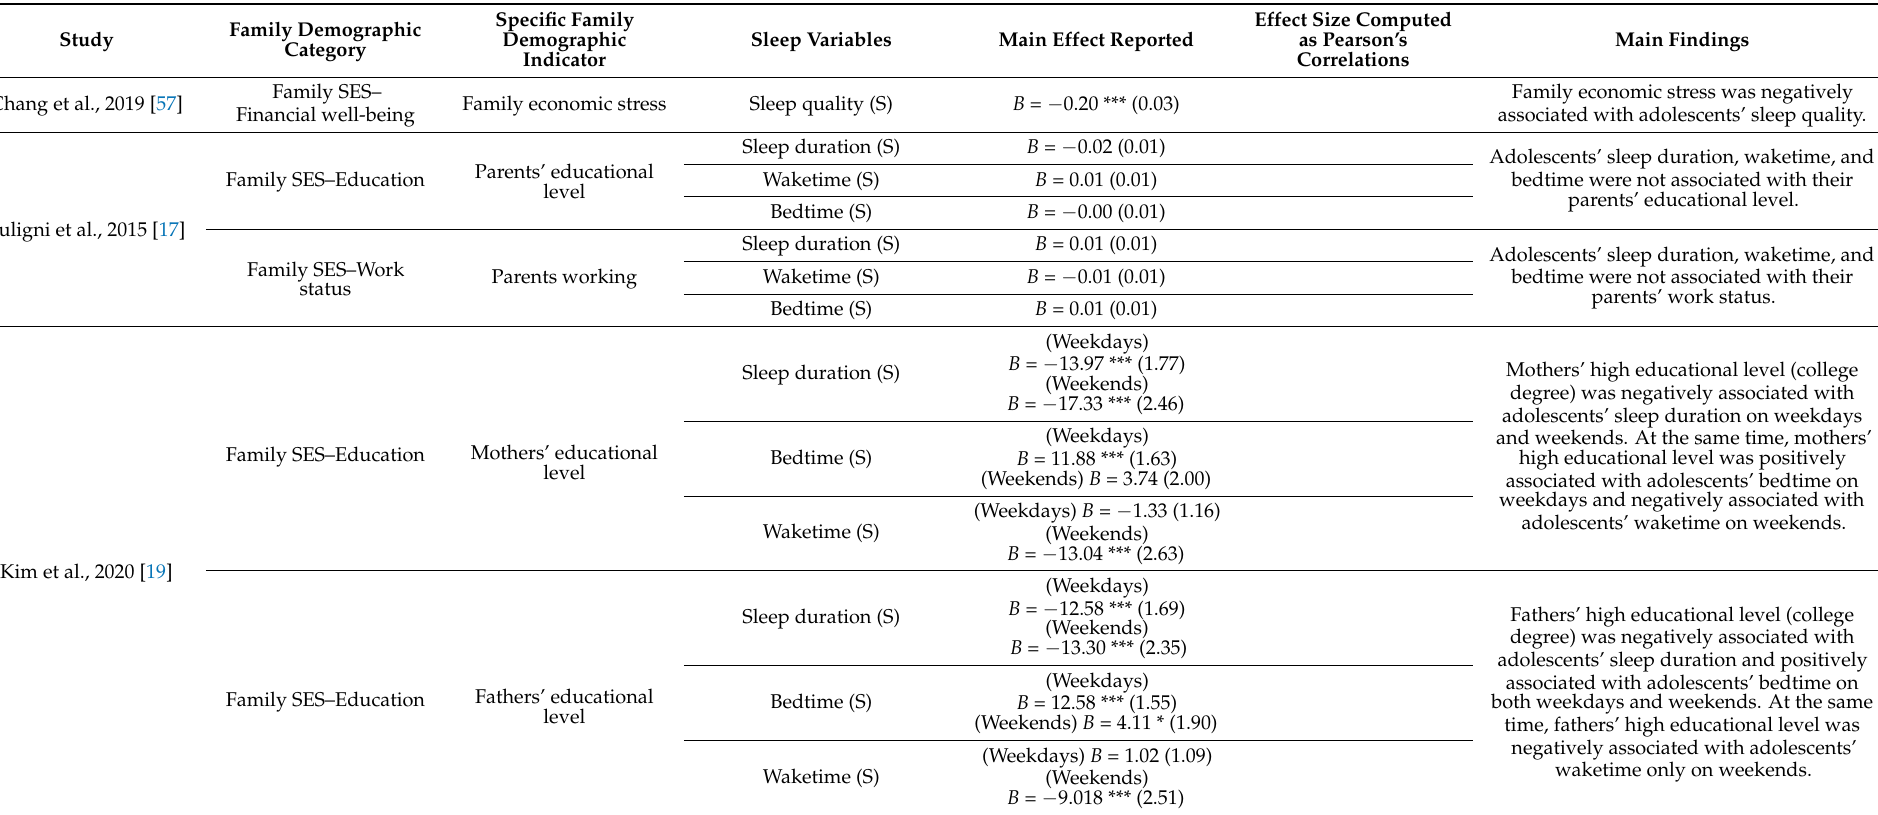
Table 2. Longitudinal Associations Between Demographic Indicators of the Family and Adolescents’